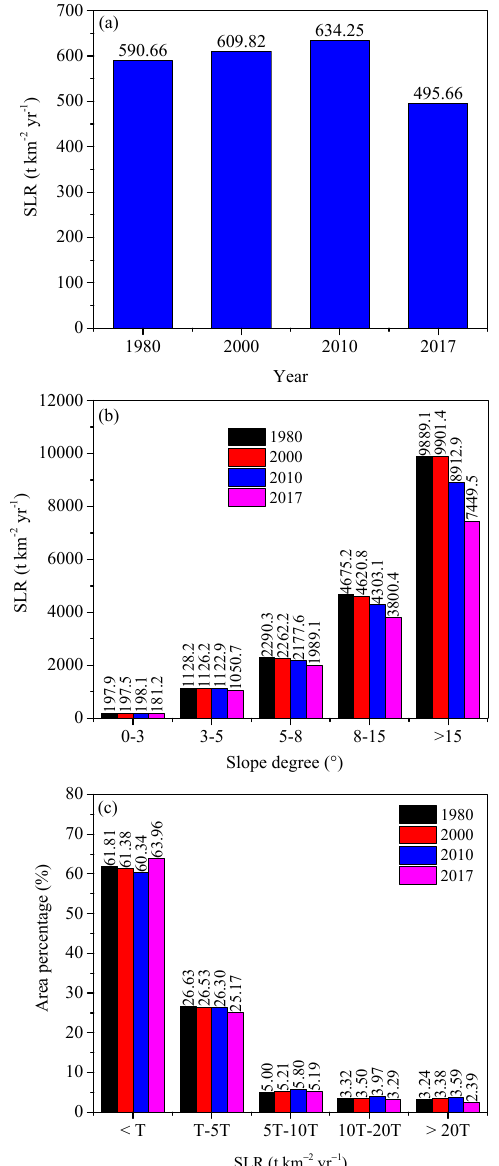
Figure 5. Soil loss rates (SLR) for ( a ) the study region, and ( b ) the areas, and ( c ) their area percentages on different slope ranges in 1980, 2000, 2010, and 2017. Note: T = 200 t·km − 2 ·yr − 1 .